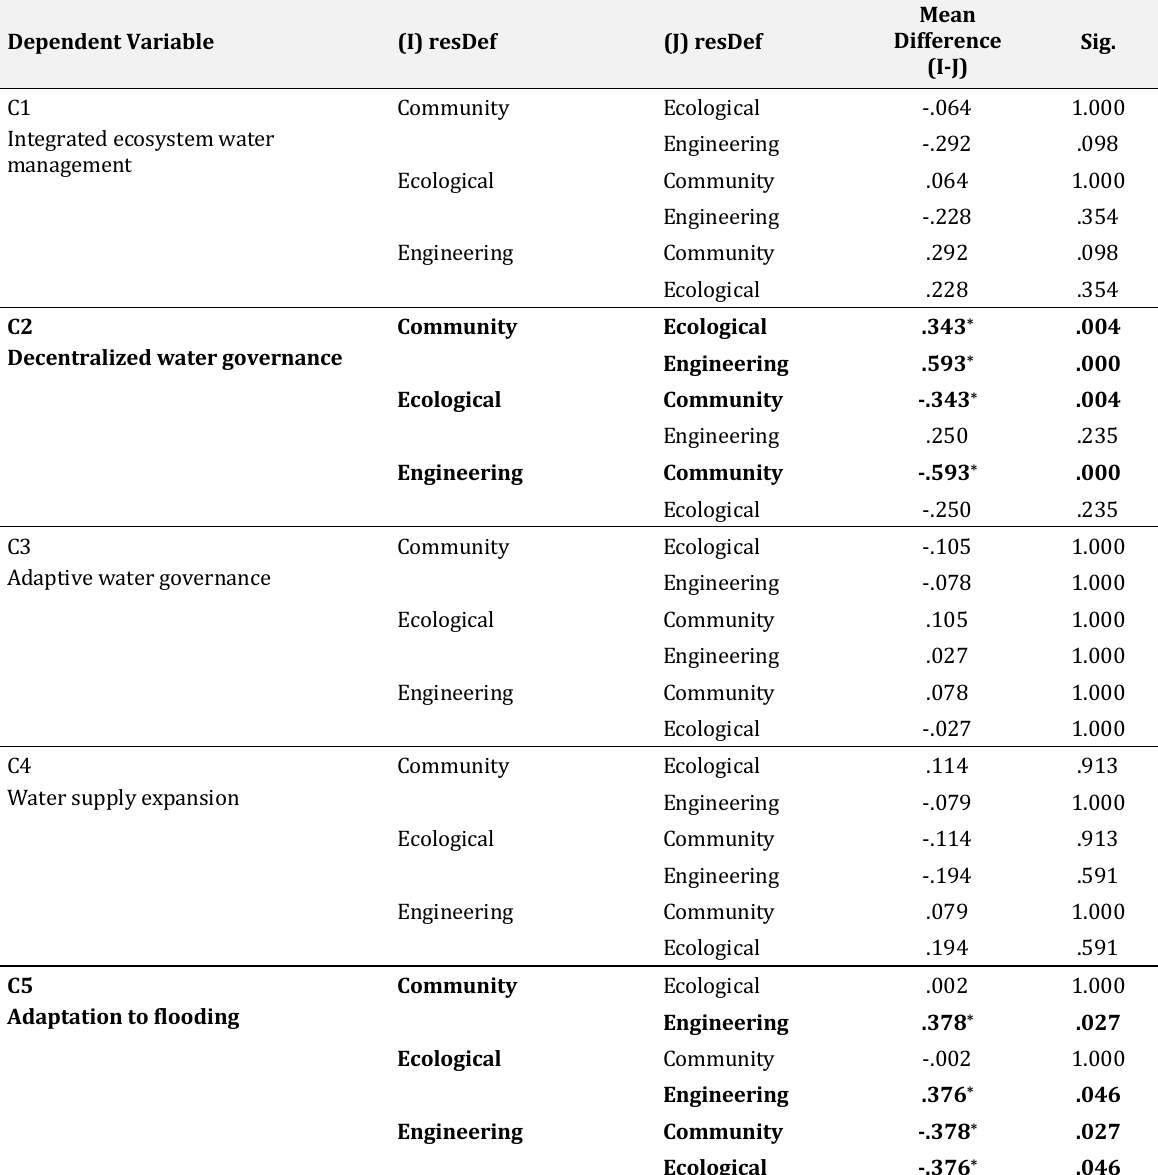
Table A1.1 MANOVA and post-hoc tests (Bonferroni). The multiple comparison table shows the two components that showed statistically significant differences in the choices of definitions (C2 and C5), while C1, C3 and C4 do not vary significantly by definition. In sum, people who chose the community resilience definition we more likely to rate C2 higher than those who chose ecological resilience and much more likely than those who chose the engineering definition. People who chose community resilience were also more likely to rate C5 higher than those who preferred the engineering definition. Respondents who preferred engineering definitions of resilience were much less likely to rate C5